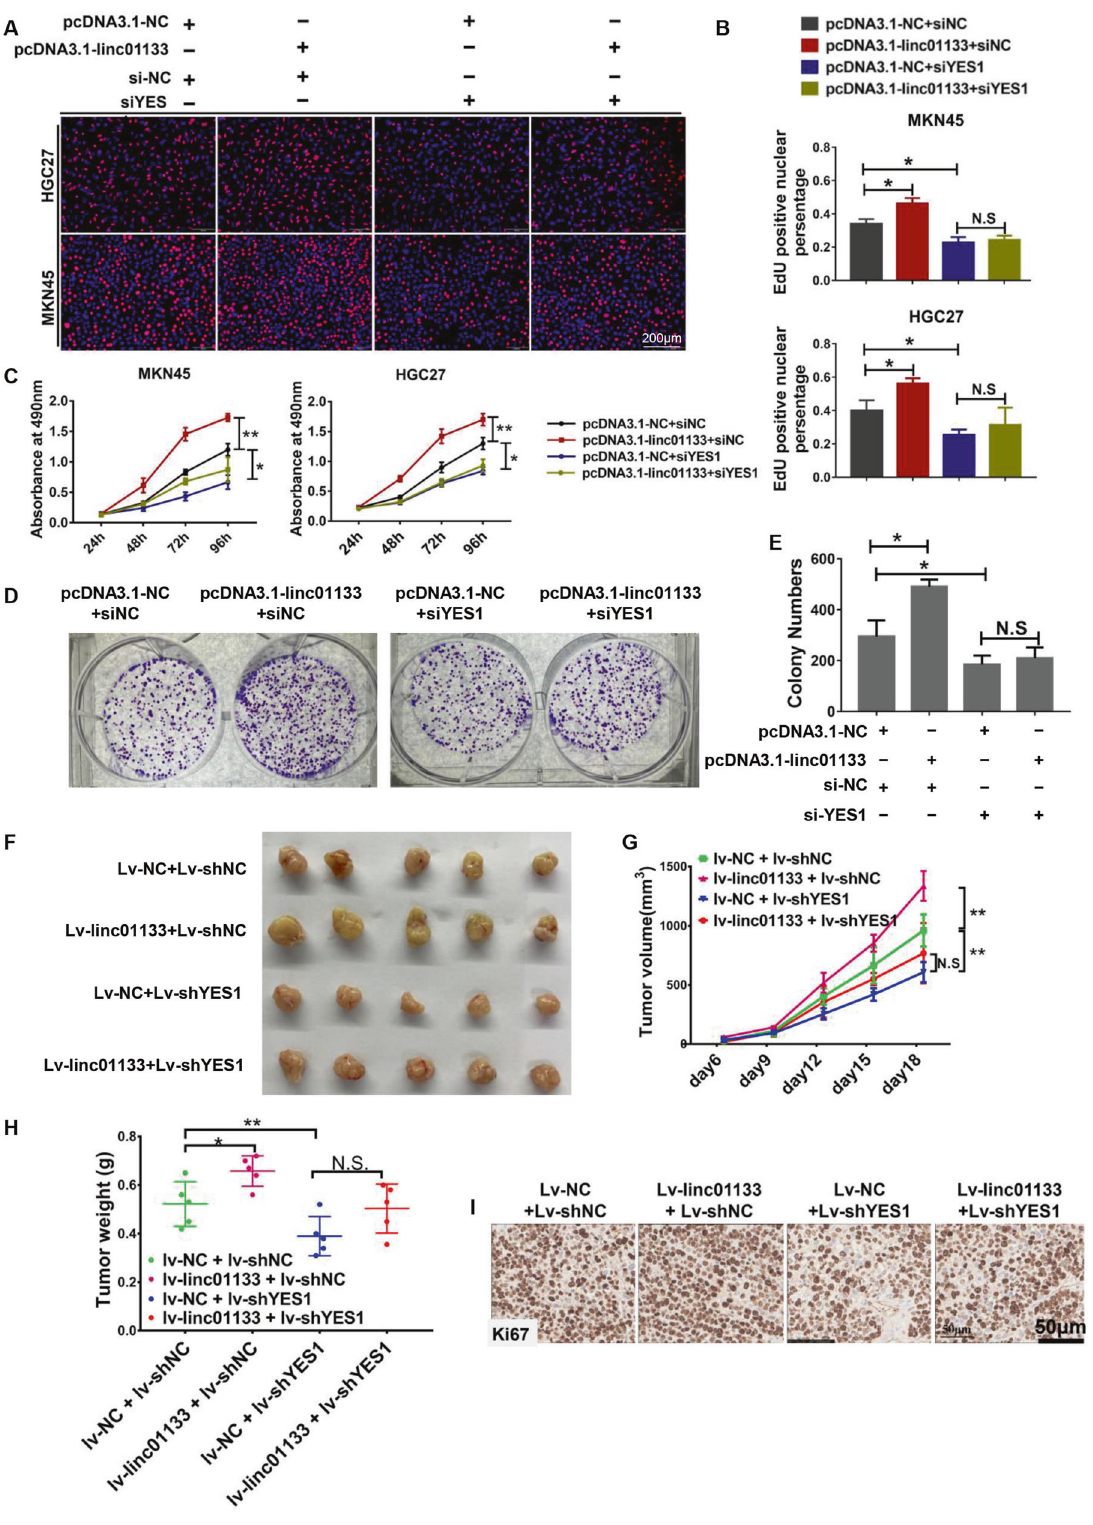
Fig. 6 YES1 confers the function of linc01133 in vitro and in vivo. Knocking-down YES1 ameliorated linc01133 induced accelerating cell growth demonstrated by EdU assay ( A, B ) and MTS assay ( C ). D – E Colony formation assay showed decreased colony numbers formed by MKN45 cells co-transfected with pcDNA3.1-linc01133 and si-YES1. F – H The sizes, growth curves and weights of tumor xenografts showed that over-expression of linc01133 signi fi cantly enhanced tumor growth while simultaneous YES1 knocking-down inhibited tumor growth. I Ki-67 immuno-staining showed that knocking-down YES1 ameliorated linc01133 induced Ki-67 positive cells. Data are shown as mean ± SD, * P < 0.05, ** P < 0.01, N.S no signi fi cance.